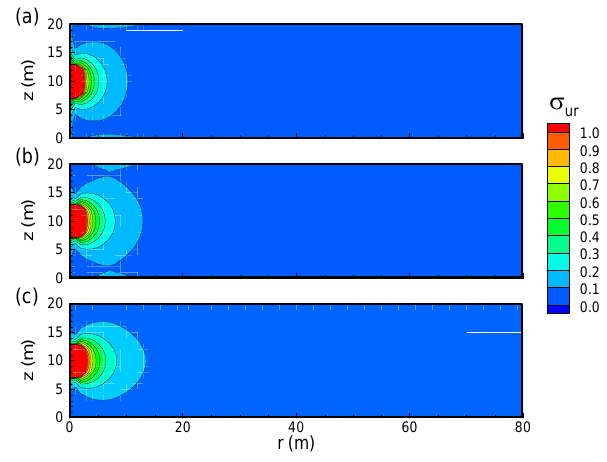
Fig. 5. The solutions of velocity standard deviation for r-direction at t= 80 day: (a) r-correlation length ( r) =1.0 m, (b) r-correlation length ( r) =5.0 m, and (c) r-correlation length ( r) =10.0 m.